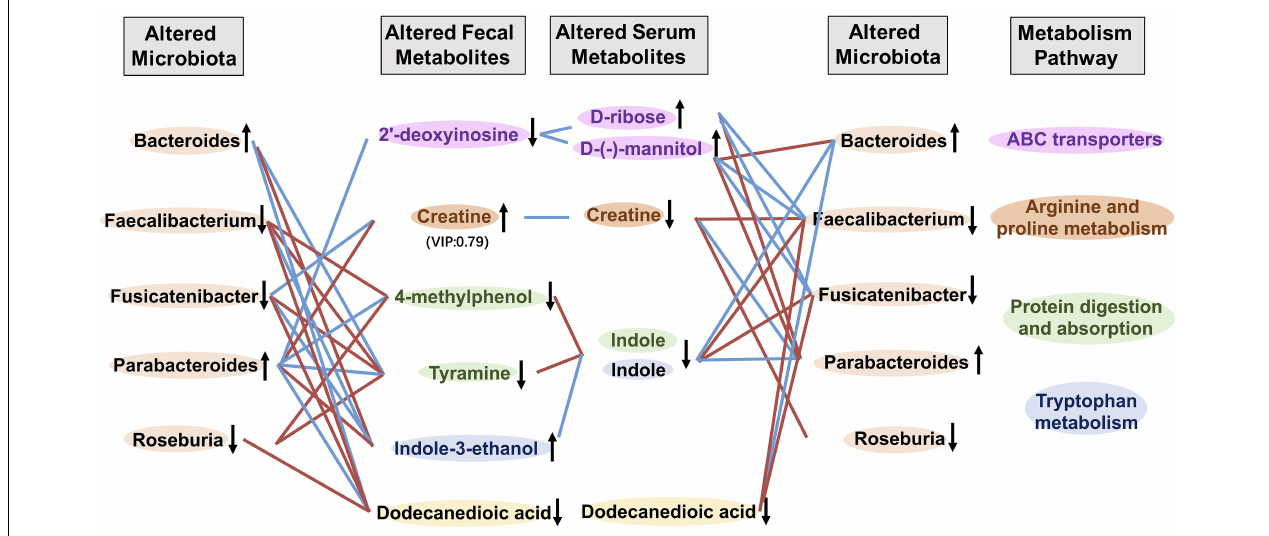
FIGURE 5 | Correlation analysis between metabolites and gut microbiota. Correlation profile of altered gut microbiota, fecal and serum metabolites in frailty based on the Spearman’s correlation analysis. Fecal metabolites and serum metabolites of the same color were included in the metabolism pathway with the same color. ↑ and ↓ indicated higher and lower concentration of metabolites or abundance of microbiota, respectively. Red and blue lines indicated positive and negative correlations, respectively.